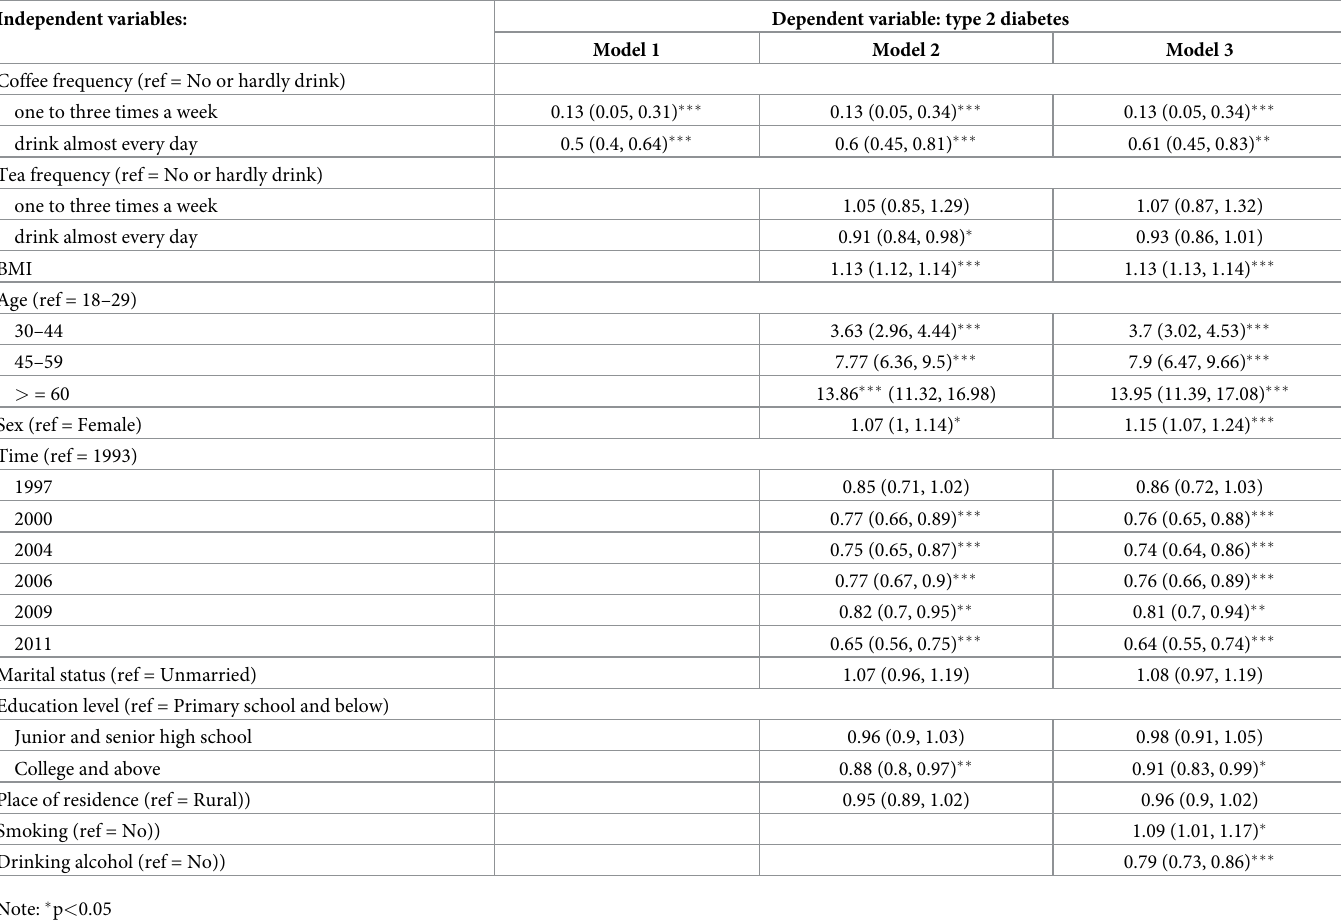
Table 3. Results of fixed effects regression analysis investigating the association of coffee consumption with the risk of type 2 diabetes among Chinese adults (1993– 2011). Independent